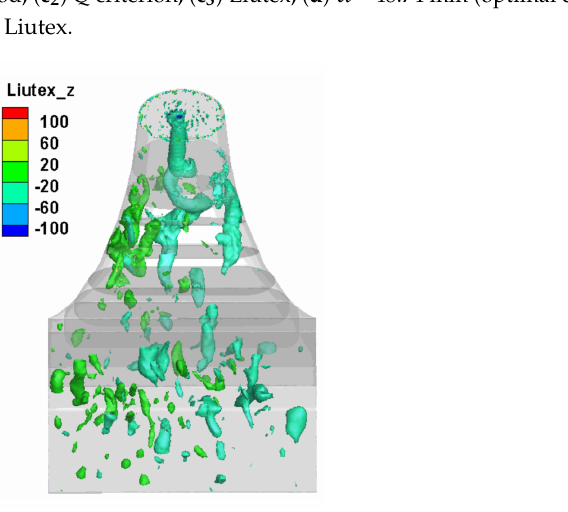
Figure 14. Analysis of streamwise vortex